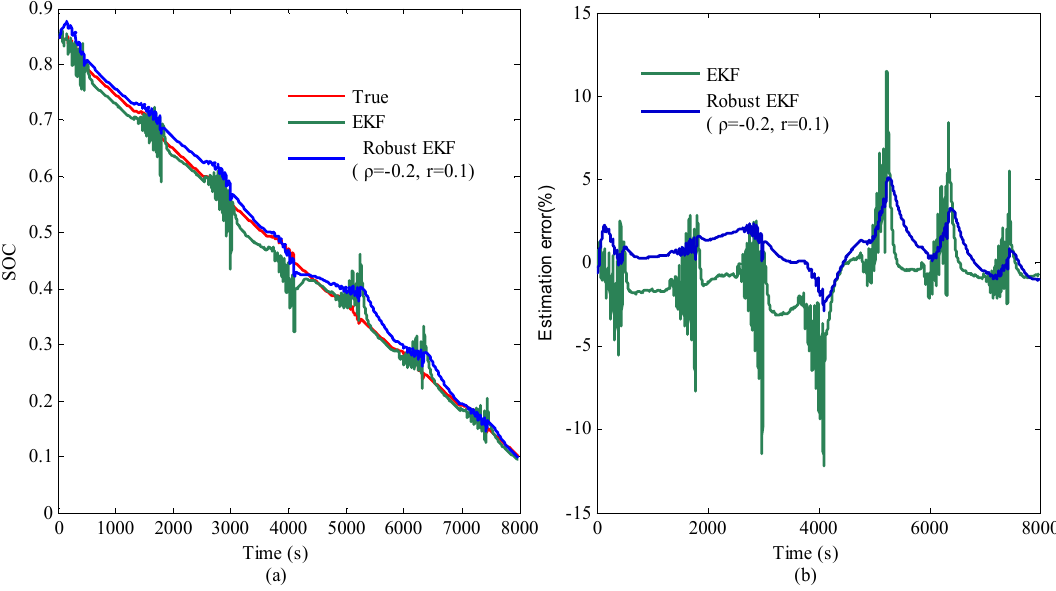
Figure 9. Comparing results of SOC estimation with the proposed Robust EKF and EKF for self-defined HPPC cycles.